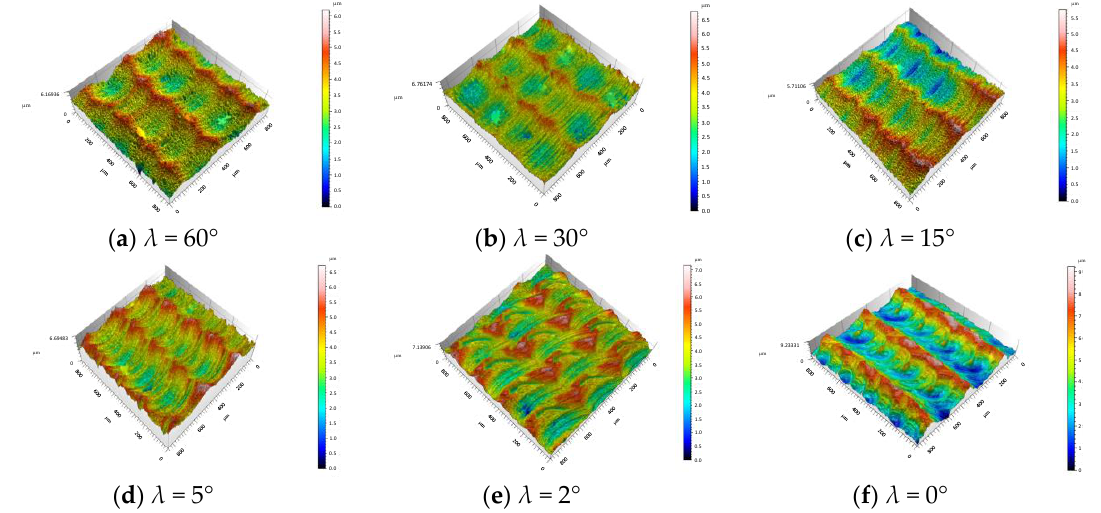
Figure 13. Experimental measurement of surface topography at different λ .